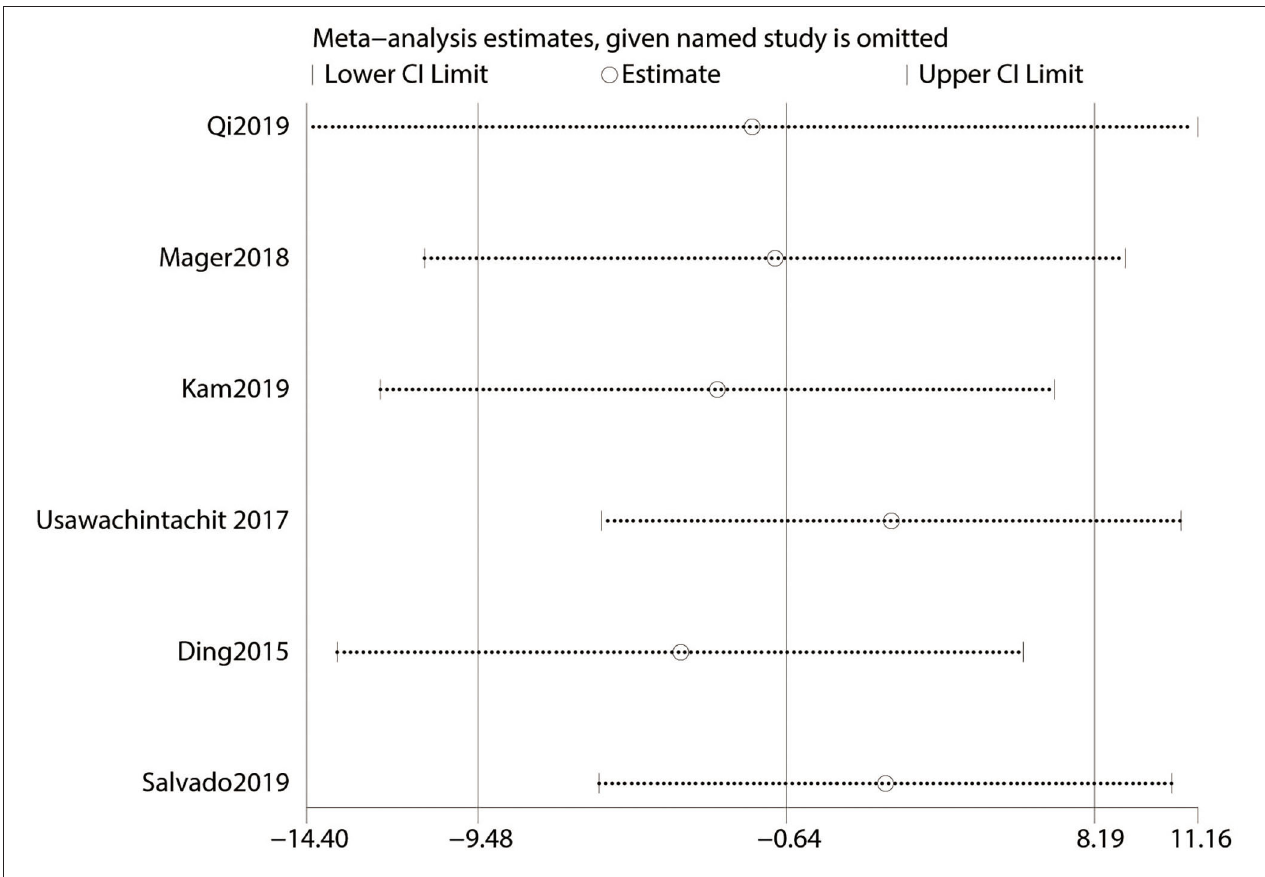
FIGURE 3 | Sensitivity analysis of operative time.